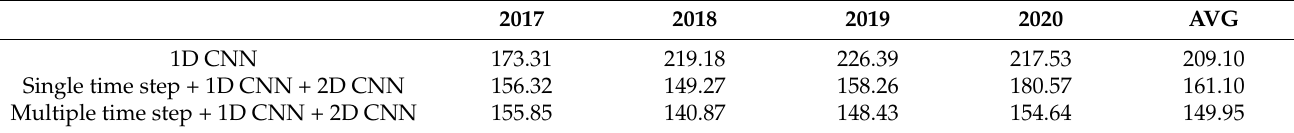
Table 6. Twenty-four hour distance error of single isobaric surface forecast (km).